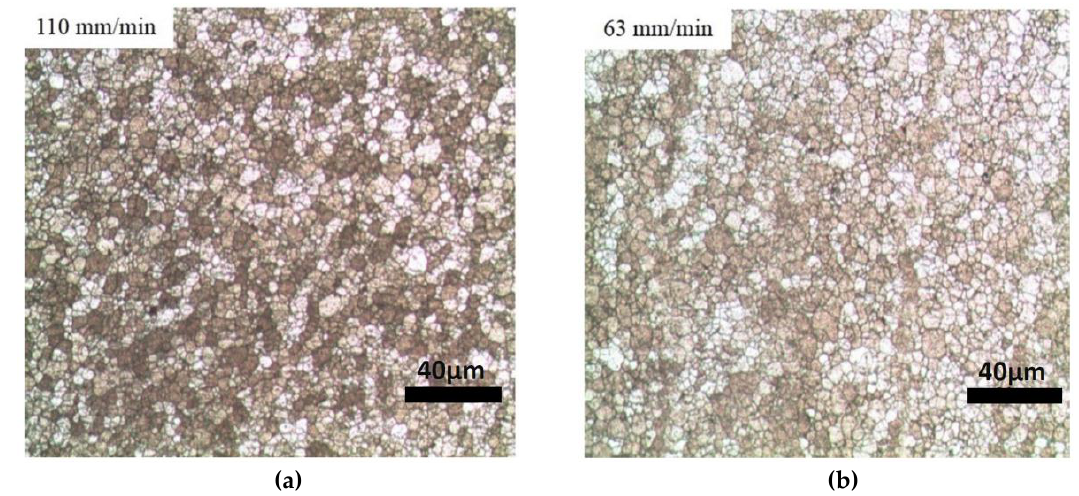
Figure 8. Optical microstructure of Nugget Zone (NZ) in highest ( a ) and lowest ( b ) welding speed ( a ) 110 mm/min welding speed ( b ) 63 mm/min welding speed.